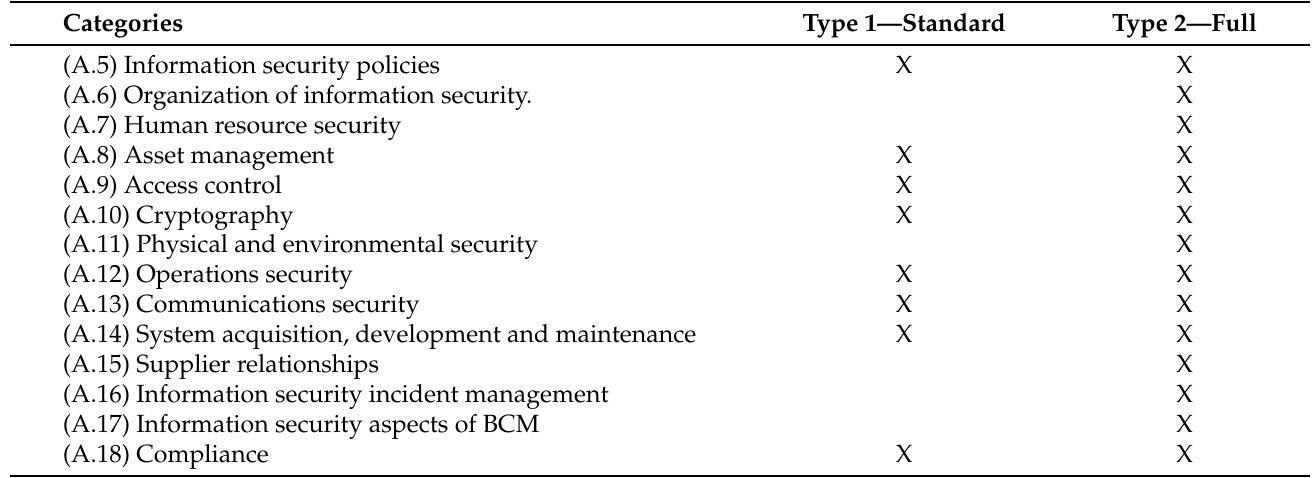
Table 1. Identification of the categories considered to “Type 1” and “Type 2”